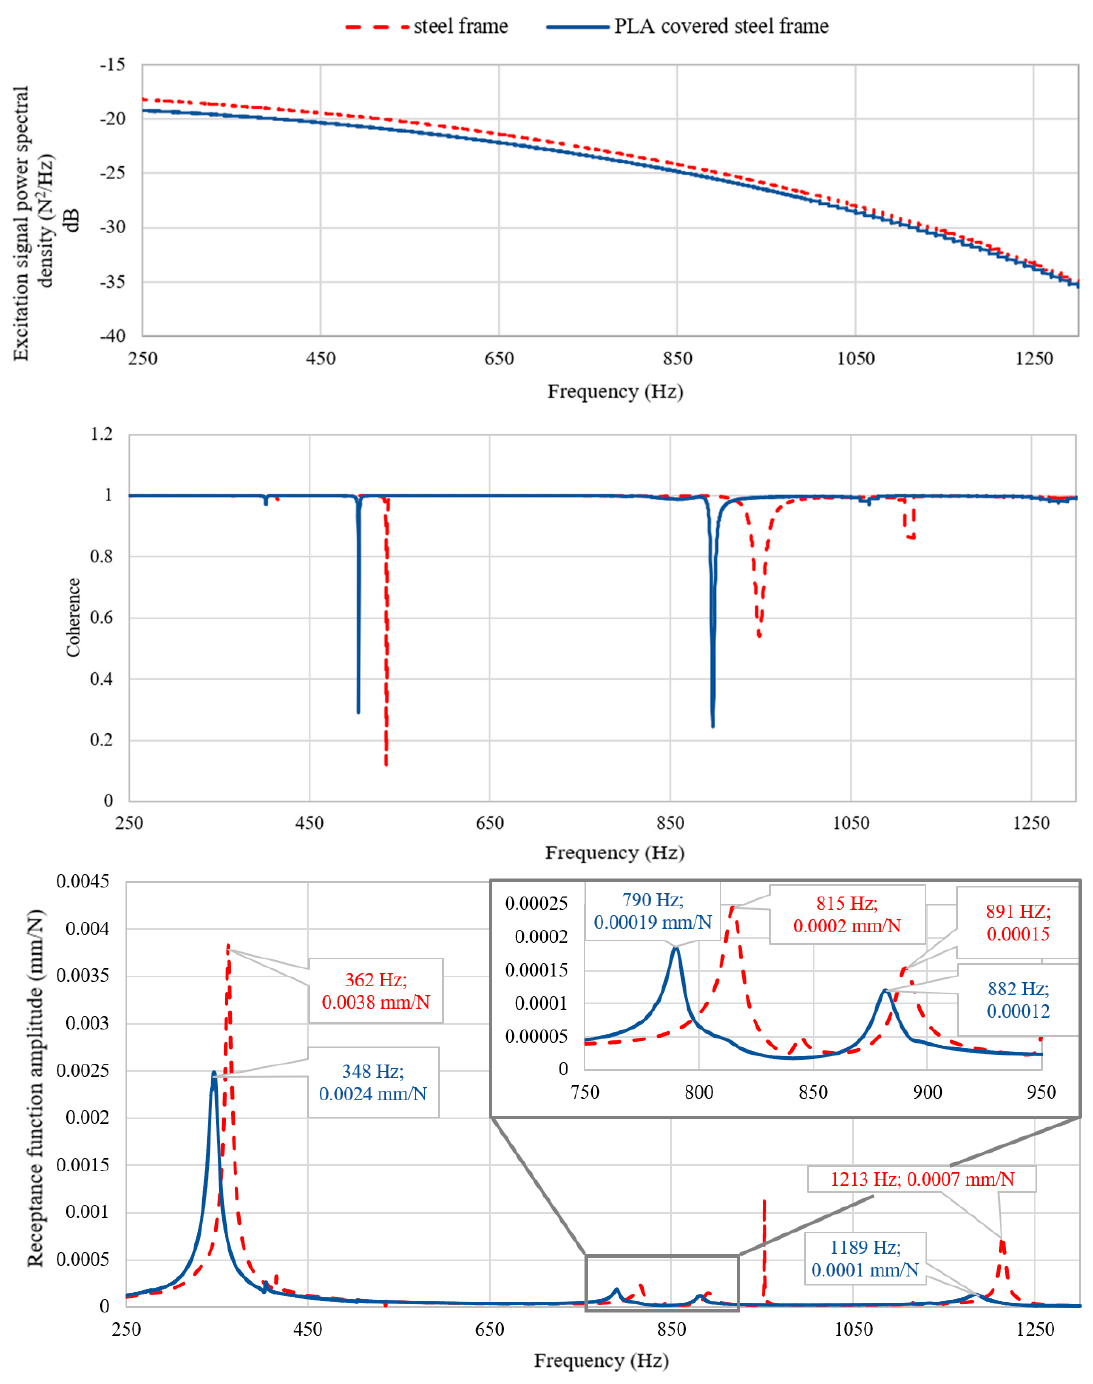
Figure 13. Comparison of receptance functions for steel frame and a steel frame with PLA covers.